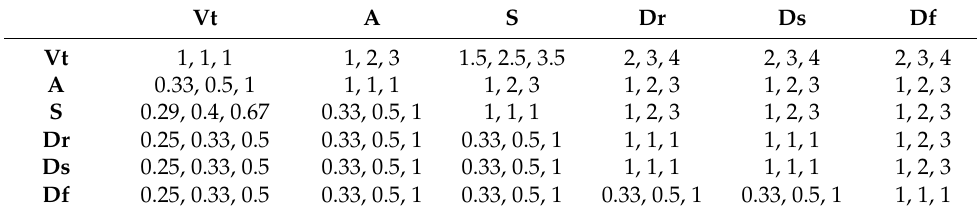
Table 6. Fuzzy comparison pairwise matrix.